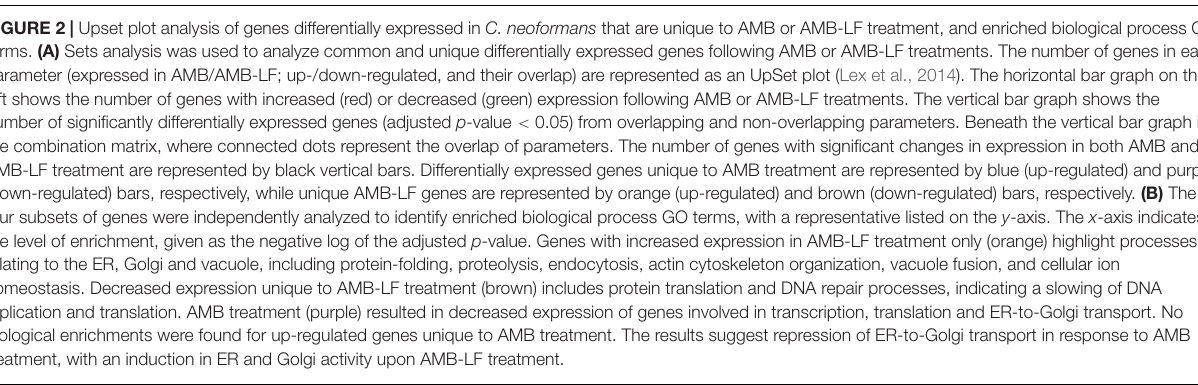
FIGURE 2 | Upset plot analysis of genes differentially expressed in C. neoformans that are unique to AMB or AMB-LF treatment, and enriched biological process GO terms. (A) Sets analysis was used to analyze common and unique differentially expressed genes following AMB or AMB-LF treatments. The number of genes in each parameter (expressed in AMB/AMB-LF; up-/down-regulated, and their overlap) are represented as an UpSet plot (Lex et al., 2014). The horizontal bar graph on the left shows the number of genes with increased (red) or decreased (green) expression following AMB or AMB-LF treatments. The vertical bar graph shows the number of significantly differentially expressed genes (adjusted p -value < 0.05) from overlapping and non-overlapping parameters. Beneath the vertical bar graph is the combination matrix, where connected dots represent the overlap of parameters. The number of genes with significant changes in expression in both AMB and AMB-LF treatment are represented by black vertical bars. Differentially expressed genes unique to AMB treatment are represented by blue (up-regulated) and purple (down-regulated) bars, respectively, while unique AMB-LF genes are represented by orange (up-regulated) and brown (down-regulated) bars, respectively. (B) The four subsets of genes were independently analyzed to identify enriched biological process GO terms, with a representative listed on the y -axis. The x -axis indicates the level of enrichment, given as the negative log of the adjusted p -value. Genes with increased expression in AMB-LF treatment only (orange) highlight processes relating to the ER, Golgi and vacuole, including protein-folding, proteolysis, endocytosis, actin cytoskeleton organization, vacuole fusion, and cellular ion homeostasis. Decreased expression unique to AMB-LF treatment (brown) includes protein translation and DNA repair processes, indicating a slowing of DNA replication and translation. AMB treatment (purple) resulted in decreased expression of genes involved in transcription, translation and ER-to-Golgi transport. No biological enrichments were found for up-regulated genes unique to AMB treatment. The results suggest repression of ER-to-Golgi transport in response to AMB treatment, with an induction in ER and Golgi activity upon AMB-LF